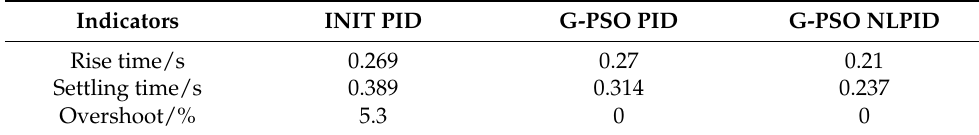
Figure 9. Experimental response curves of different controllers. Table 6. Detailed indicators of response curves for